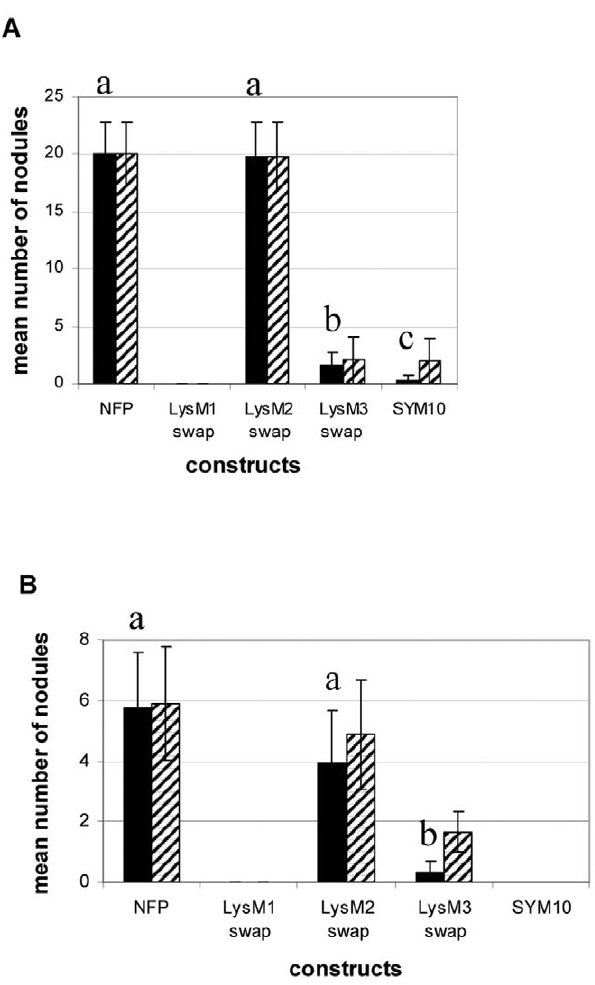
Figure 5. LysM domains of NFP do not have equivalent functions for nodulation. Nodules were counted on nfp roots transformed with pNFP:NFP-NFP (‘‘NFP’’), LysM1 swap, LysM2 swap, LysM3 swap and pNFP:SYM10-NFP (‘‘SYM10’’) constructs, 21 dpi with wild type S. meliloti in a sepiolite/sand mixture (A) (nodulation was assayed for 12 to 37 plants) or in growth pouches (B) (nodulation was assayed for 11 to 32 plants). Bars correspond to the 95% confidence interval. Black bars represent average nodule numbers on the total number of plants tested, and hatched bars represent mean numbers of nodules on nodulated plants only. In each condition, a Mann-Whitney statistical test was performed on the number of nodules observed on the total number of plants and the superscript letter corresponds to the different categories obtained in that way (i.e the same letter indicates a similar mean, within the same